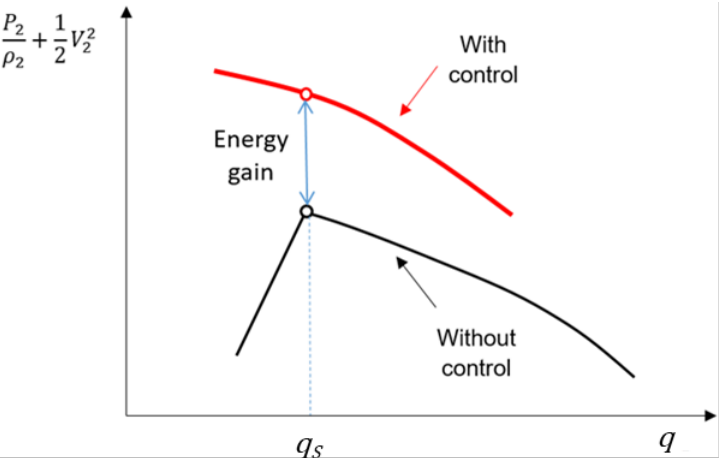
Figure 9. Energy gain due to the active flow control system.